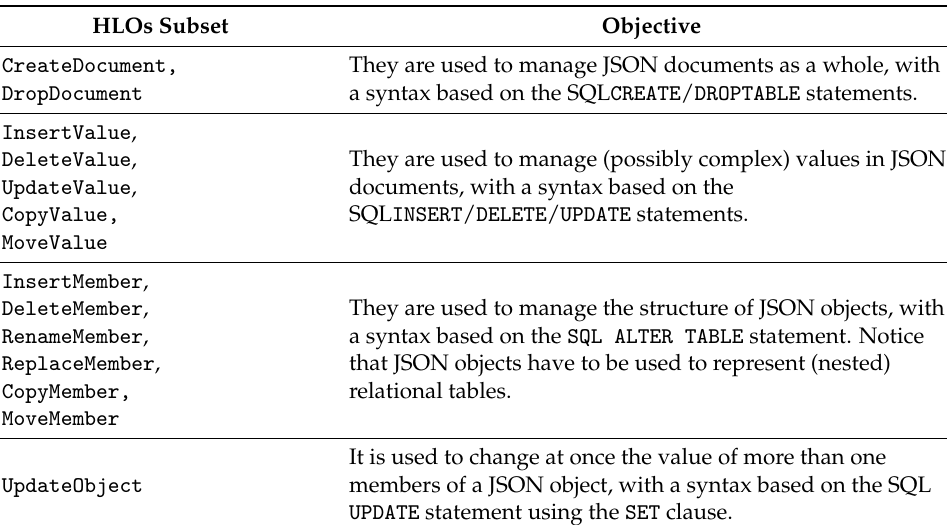
Table 1. The four subsets of HLOs of JUpdate and their inspiration by the SQL